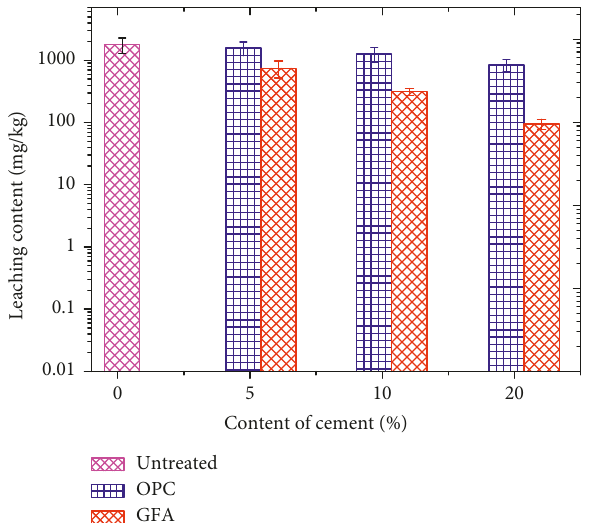
Figure 5: Pb content of the solidified/stabilized soils in the DTPA